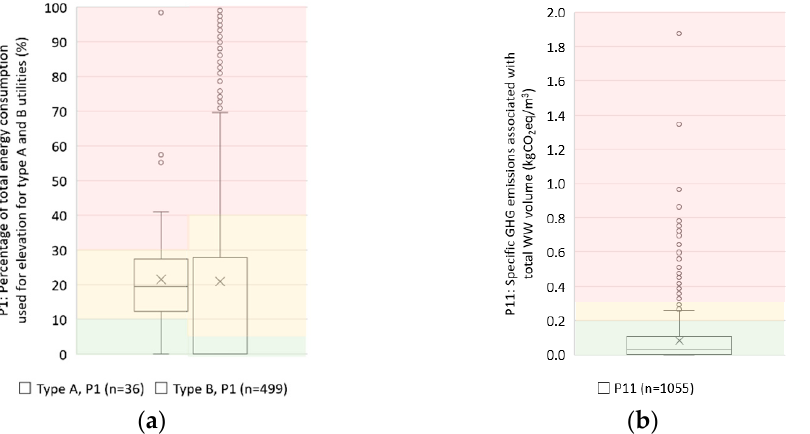
Figure 5 . Results of evaluation at national level for ( a ) percentage of total energy consumption used for pumping (P1) for type A utilities (left) and type B utilities (right) and ( b ) specific GHG emissions associated with wastewater treated volume (P11).